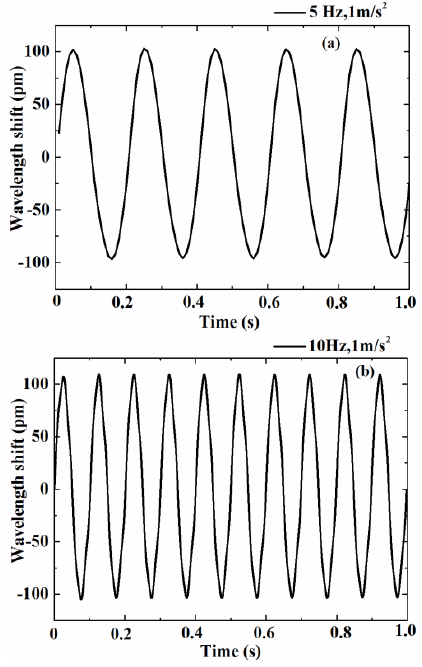
Figure 6. Time domain waveform of the sensor at 5 Hz ( a ) and 10 Hz ( b ).